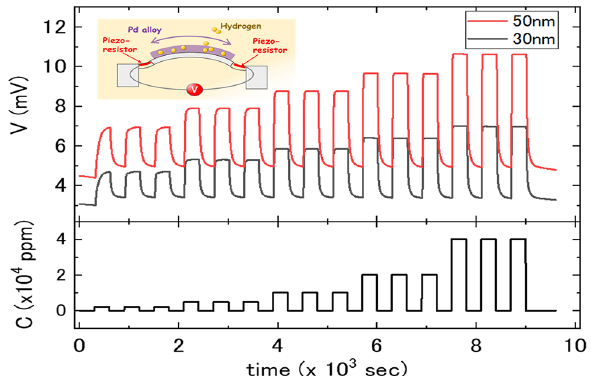
Figure 2. Responses of PdCuSi/MSS to hydrogen concentrations of 2000, 4800, 10 000, 20 000, and 40 000 ppm. Their baselines are not corrected (no offset). Horizontal axis represents time, and vertical axes represent the signals of the MSS (V) and the concentration of hydrogen (C) regulated by the mass-flow controller. Inset: Schematic diagram of stress output as piezo voltage by the MSS when hydrogen atoms are absorbed into the amorphous Pd-alloy film.